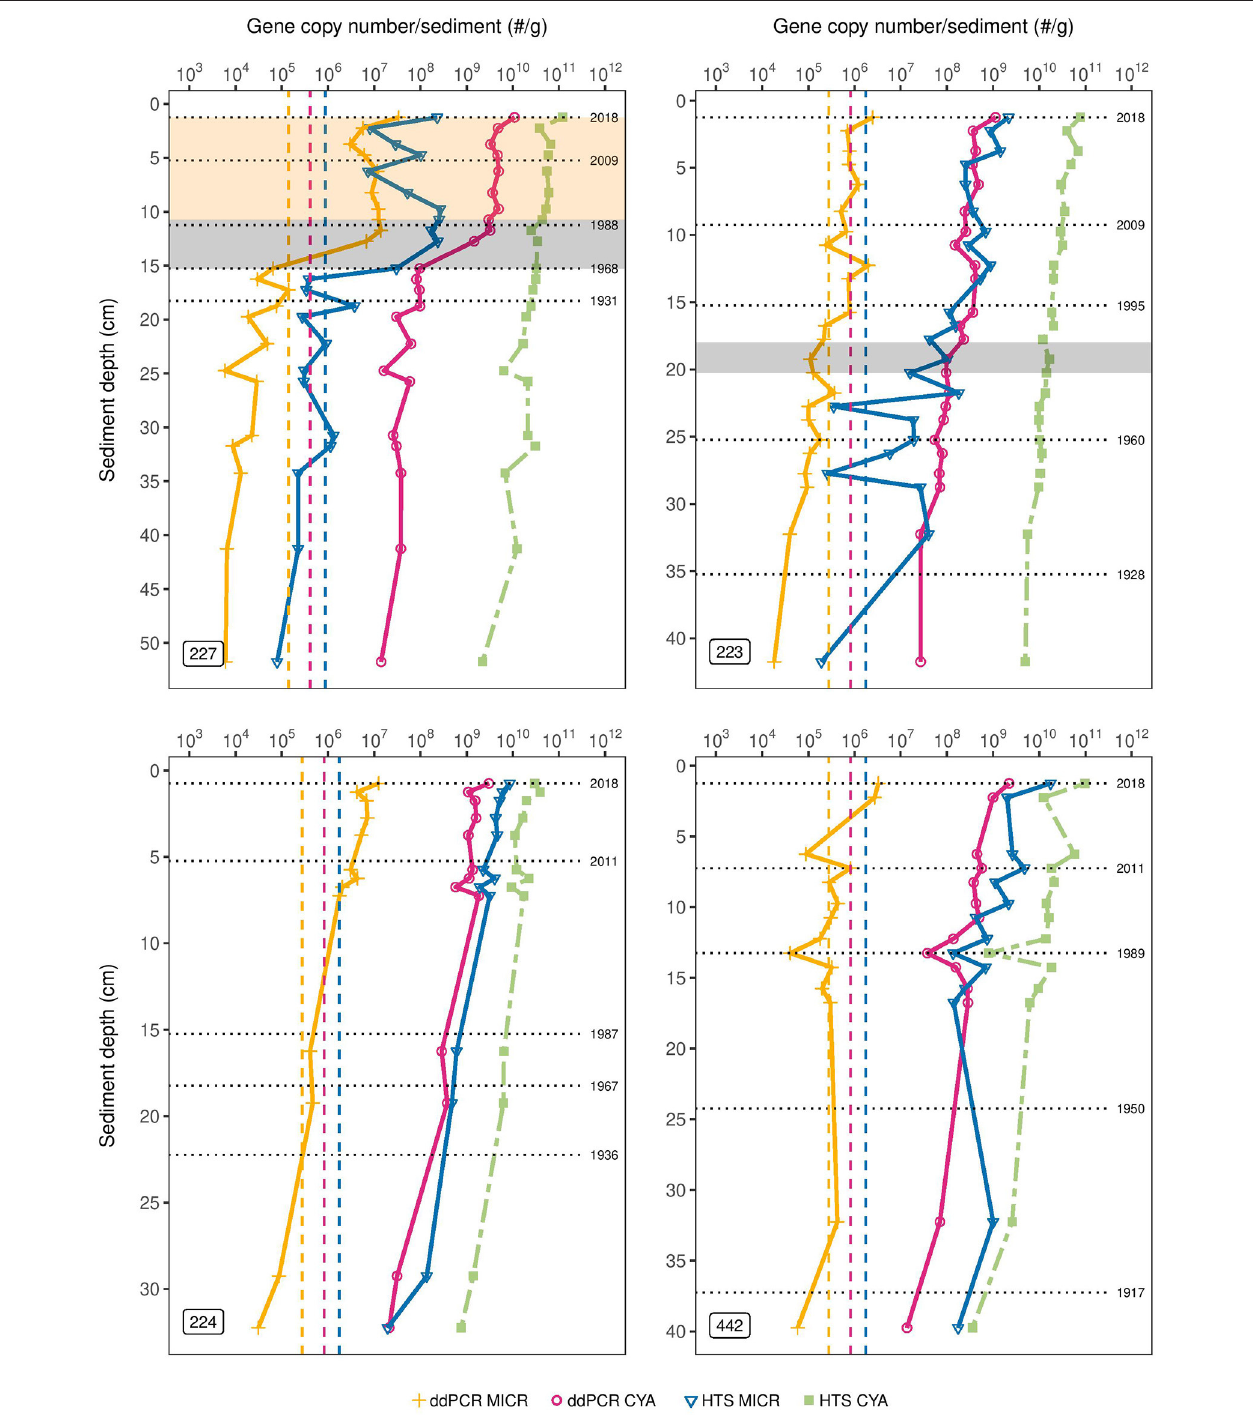
FIGURE 1 | Target gene concentrations in sediment cores of the Experimental Lakes Area, Canada from manipulated lakes 227 and 223 and reference lakes 224 and 442. Absolute gene copy numbers of Microcystis 16S rRNA (MICR) and cyanobacterial 16S rRNA (CYA) as determined through droplet digital PCR (ddPCR) are shown, along with the amplicon sequence variant counts of cyanobacterial 16S rRNA and of the Microcystis genus from high-throughput sequencing (HTS) (using SILVA). Results are normalized per gram of dry sediment and presented on a logarithmic scale. The orange and pink dashed vertical lines are the detection limits (LODs) for ddPCR-derived Microcystis 16s rRNA and cyanobacterial 16S rRNA abundances, respectively. The blue dashed vertical line is the LOD of HTS-derived abundances for both cyanobacterial 16S rRNA and Microcystis . The gray shading in the top left plot corresponds to the period of phosphorus and nitrogen loading in Lake 227 (1969–1989), while the beige shading corresponds to the period of phosphorus loading only (1990–2018). The gray shading in the top right plot corresponds to the period of sulfuric acid loading in Lake 223 (1976–1983).